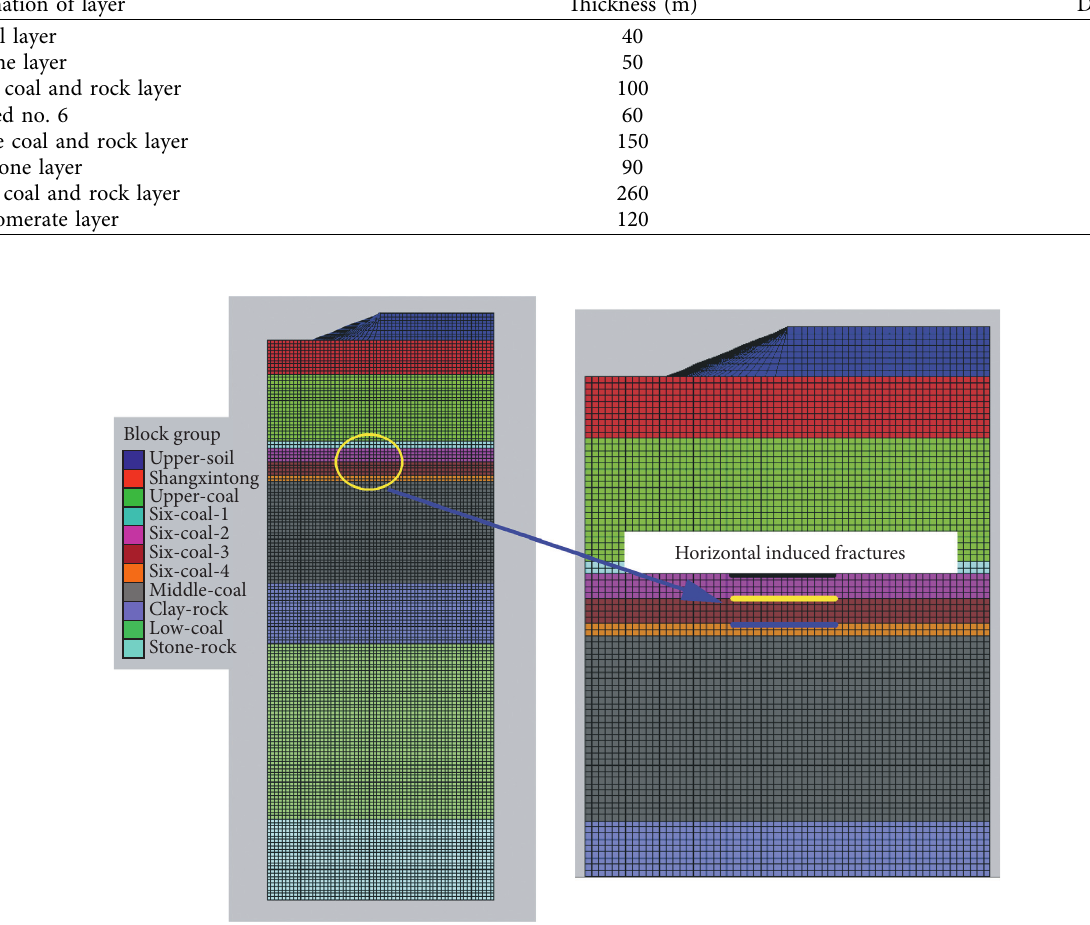
Figure 3: Numerical model of the southern slope of Shengli East No. 2 Open-Pit Coal Mine. Table 3: Geometric parameters of the model.